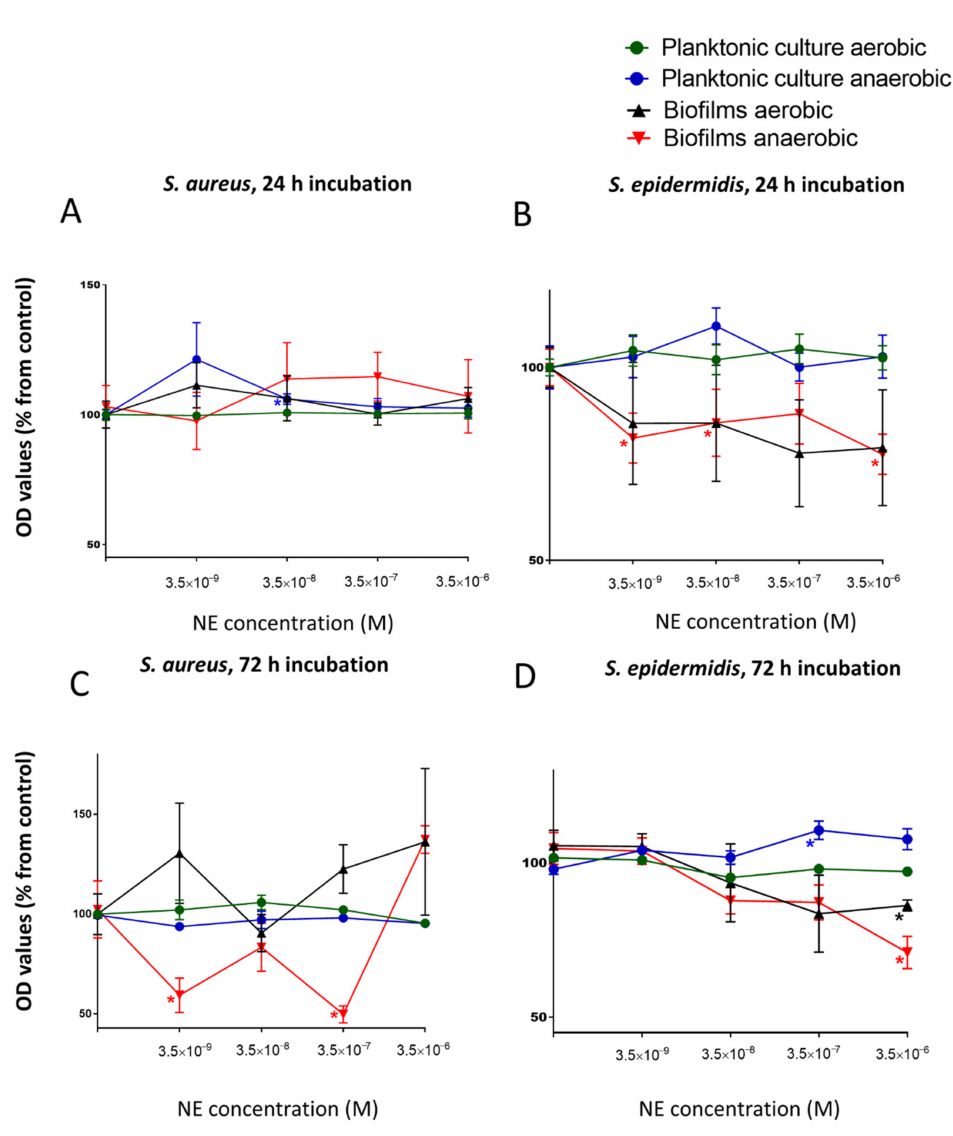
Figure 1. Impact of a physiological concentration (3.5 × 10 − 9 M) and three increased NE concentra- tions (3.5 × 10 − 8 . 3.5 × 10 − 7 , 3.5 × 10 − 6 M) on planktonic growth and biofilm formations of S. aureus ( A , C ) and S. epidermidis ( B , D ) after 24 h ( A , B ) and 72 h ( C , D ) of incubation. Error bars represent standard errors of the mean, *— p < 0.05 according to Mann-Whitney